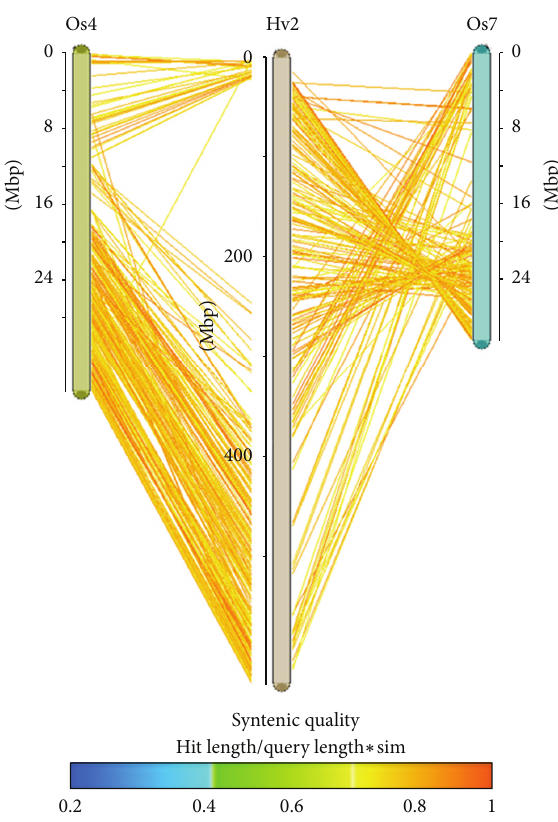
Figure 2: Example of colinearity between grass genomes. Analysis of conserved gene sequences between barley ( H. vulgare ) and rice ( O. sativa ) shows that many genes are found in colinear (syntenic) order. In this example, chromosome 2 of barley (Hv2, centre) is compared with chromosomes 4 and 7 of rice (Os4 and Os7). Each colored line represents a gene conserved between the two chromosomes, with the color indicating the strength of the syntenic relationship. It is clear that many genes from both ends of Hv2 are colinear with the ends of Os4, while the centre of the chromosome is largely colinear with Os7, but in the reverse order. Image was generated using the CrowsNest Comparative Map Viewer at MIPS